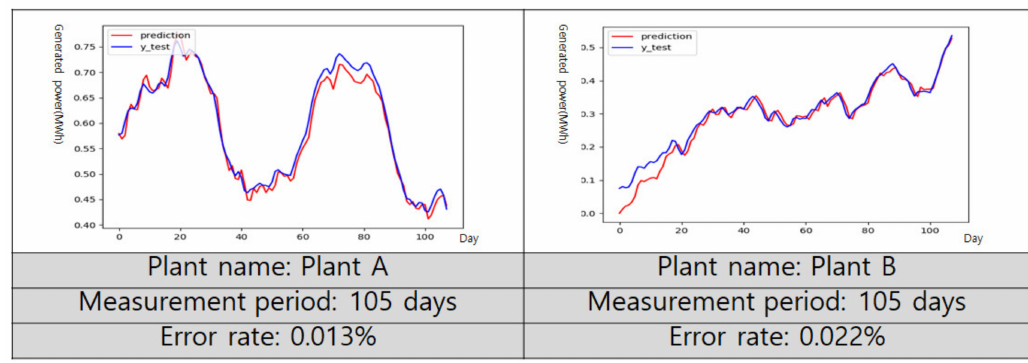
Figure 13. Power generation prediction result per